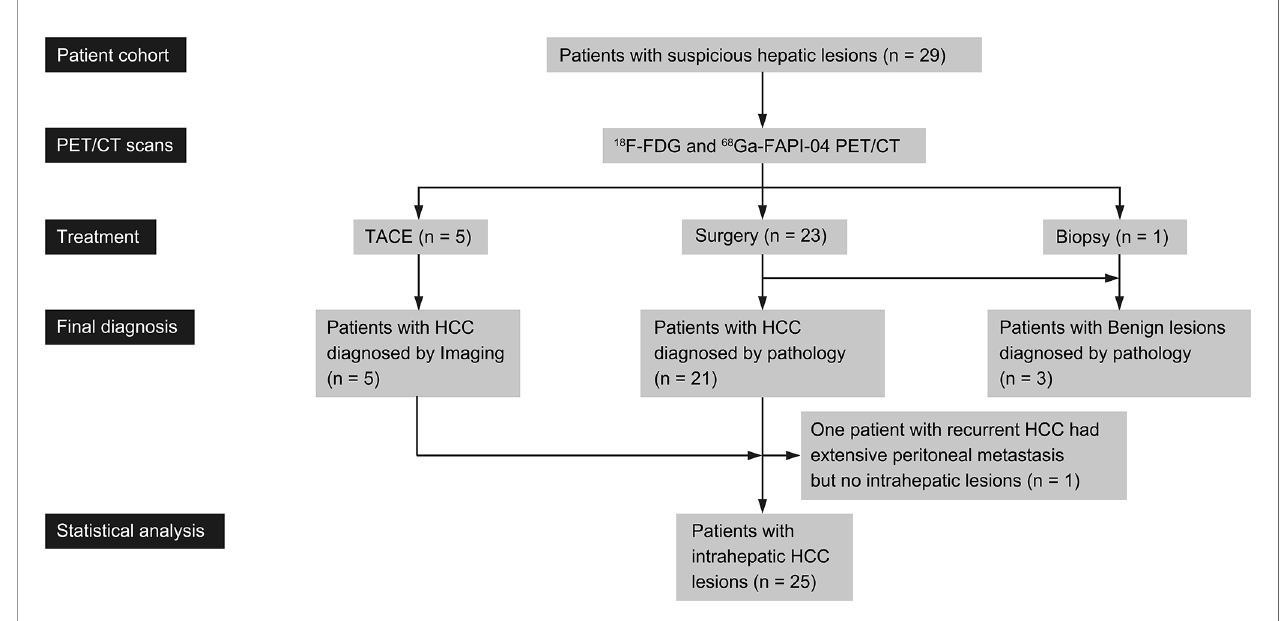
FIGURE 1 | Study fl owchart (n = number of patients).